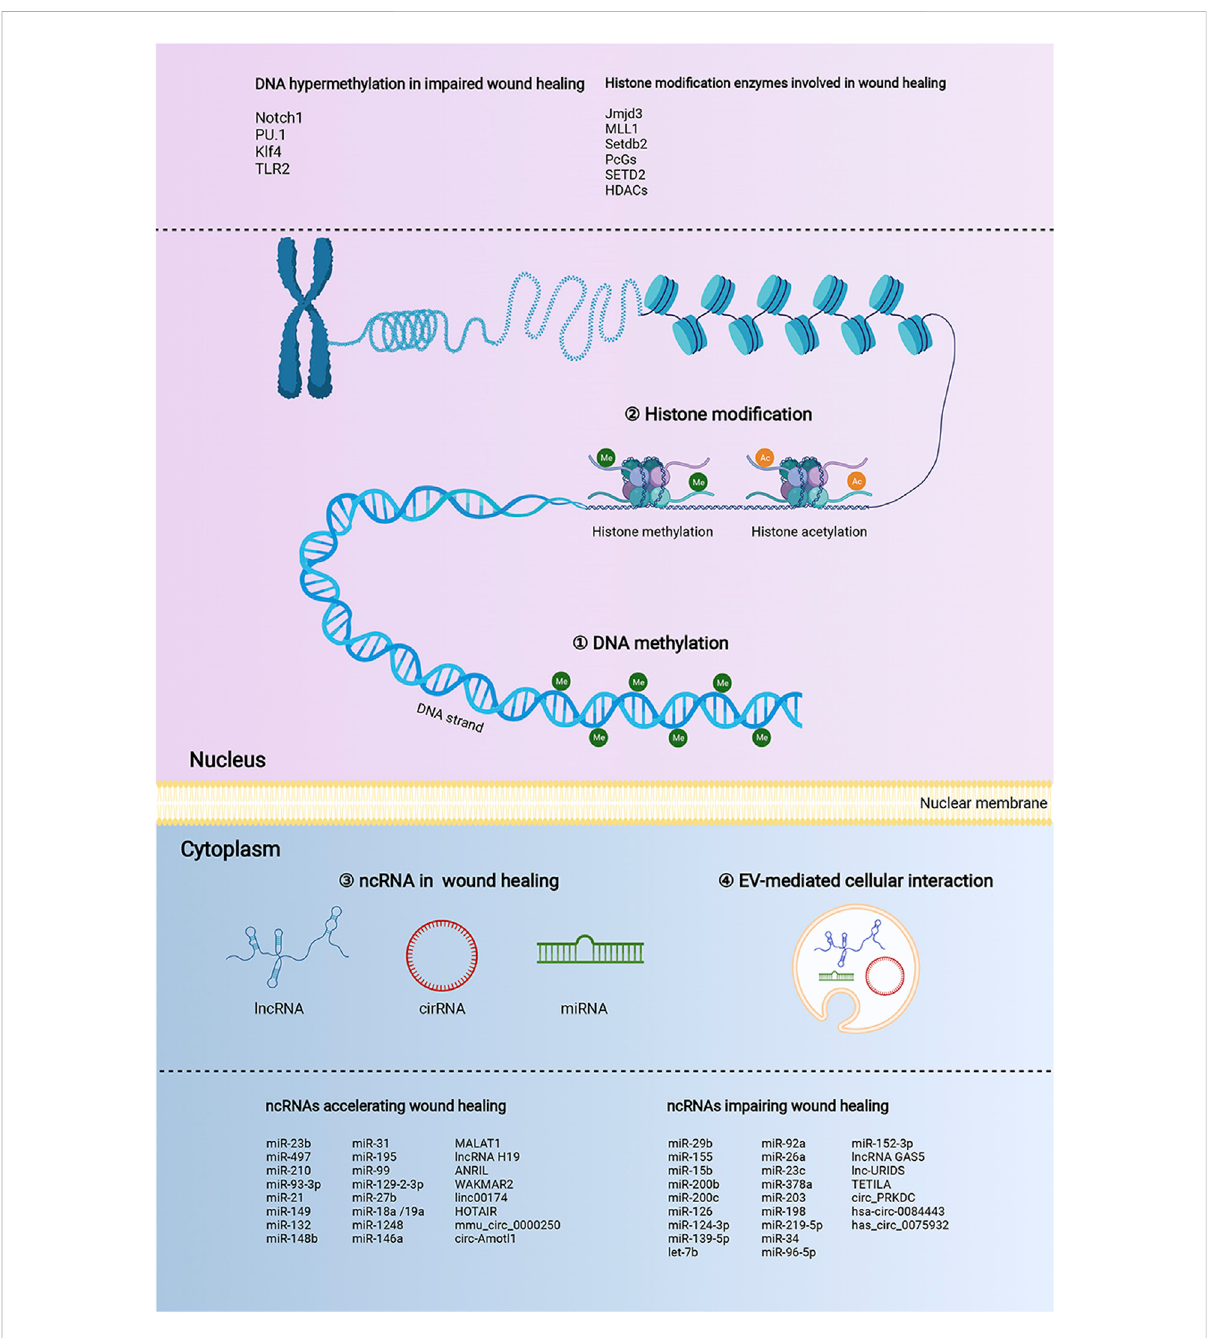
FIGURE 2 Thelandscapeoftheepigeneticregulationinwoundhealing.Theepigeneticmodi fi cationsofthewoundhealingprocessarepresentedbyDNA methylation, histonemodi fi cations,andnon-codingRNAs (ncRNAs). Inthenucleus, thenucleosomeisthefunctionalunitofthechromatin,whichis made up of DNA and histone proteins. Histone modi fi cations, including methylation (me), acetylation (ac) can regulate the transcription process by affecting the looseness of chromatin. DNA methylation refers to the transfer of a methyl group to the C5 position of cytosine in CpG islands. NcRNAsprovideadditionalepigeneticregulationinthecytoplasm,byregulatingmRNAexpressionatthelevelsoftranscription,RNAprocessing,and translation. MicroRNA (miRNA), long noncoding RNA (lncRNA), and circular RNA (circRNA) are the major ncRNA types involved in wound healing. NcRNAs enrichedand stabilized inEVs mediate skin-related cell communication. The above threeregulatory mechanismscould manipulatevarious functions and fates of multiple would-associated cells, including proliferation, migration, apoptosis, and differentiation, consequently impacting the process of wound